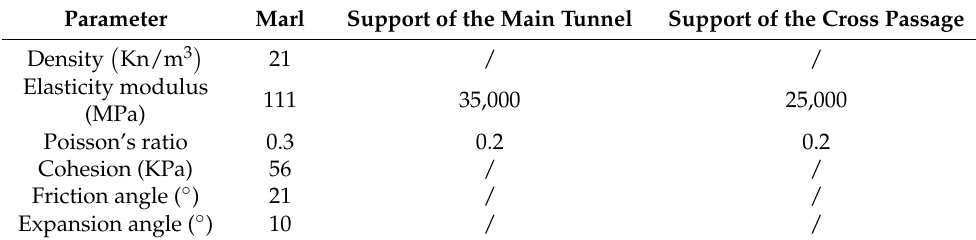
Table 2. Geomechanical characteristics retained in the 3D